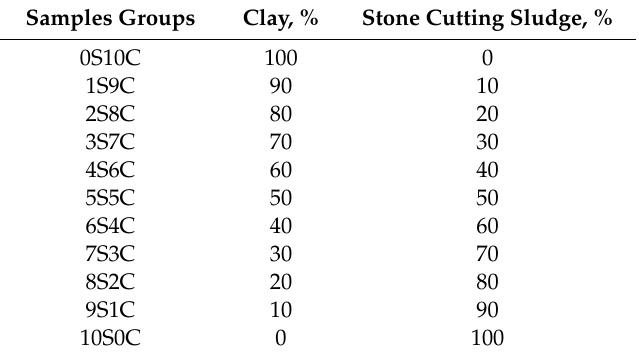
Table 1. Conformed ceramics families with combined percentages of clay and the stone cutting sludge. Samples Groups Clay, % Stone Cutting Sludge, %